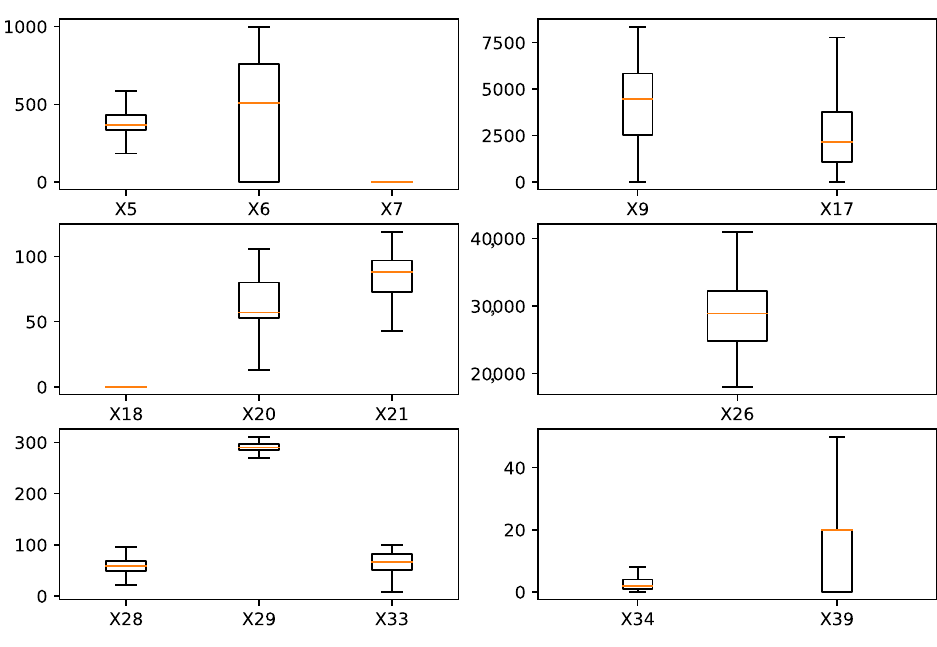
Figure 3. Box plots of selected data